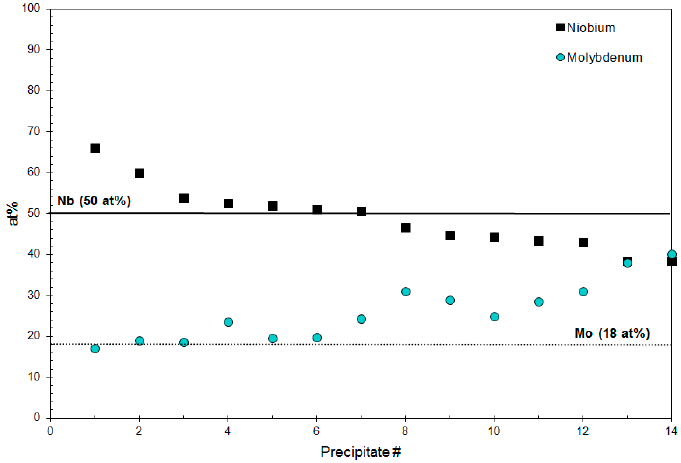
Figure 8. Measured Nb (squares) and Mo (circles) compositions vs. QXRD predicted compositions (solid line for Nb and dotted line for Mo).